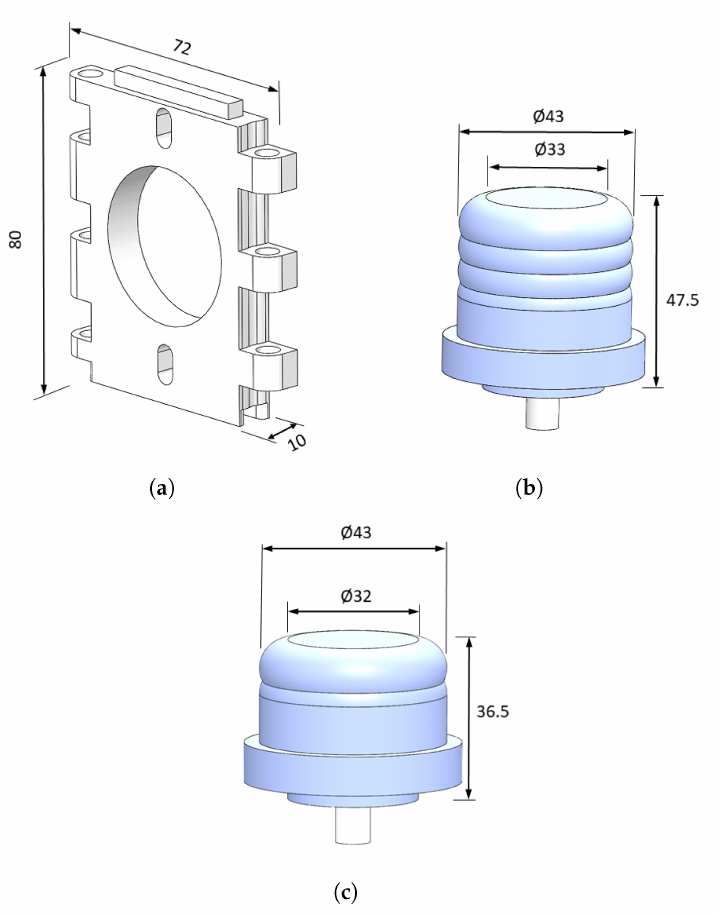
Figure 4. Main parts of a single soft gripper module with the two types of actuators: ( a ) rigid structure; ( b ) 4-bellows actuator; and ( c ) 2-bellows actuators. All dimensions are in